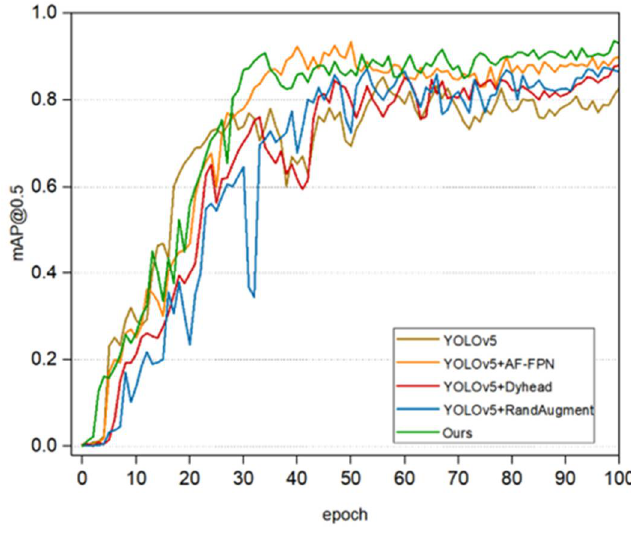
Figure 12. Changes in mAP@0.5 during training.